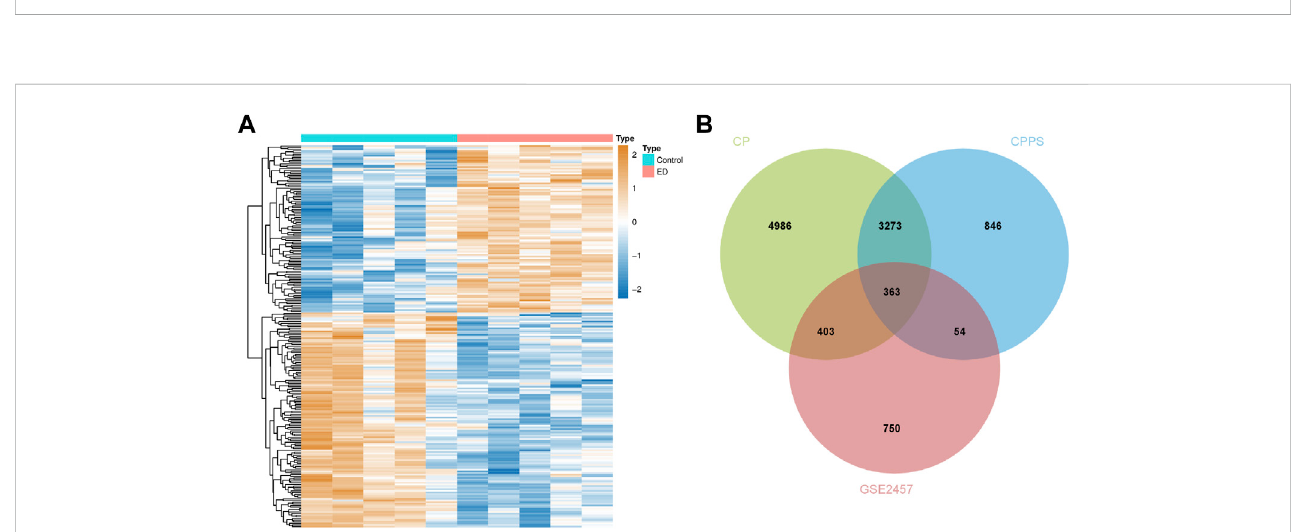
FIGURE 2 Differentially expressed CPRGs analysis. (A) The heatmap of signi fi cant CPRGs between the ED and control groups. (B) Intersection of DEGs of GSE2457 and CP/CPPS-related gene sets. ED, erectile dysfunction; CP, chronic prostatitis; CPPS, chronic pelvic pain syndrome; CPRGs, CP/CPPS-related genes; DEGs, differentially expressed